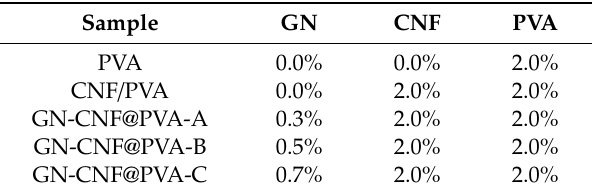
Table 1. The ratio of substance in